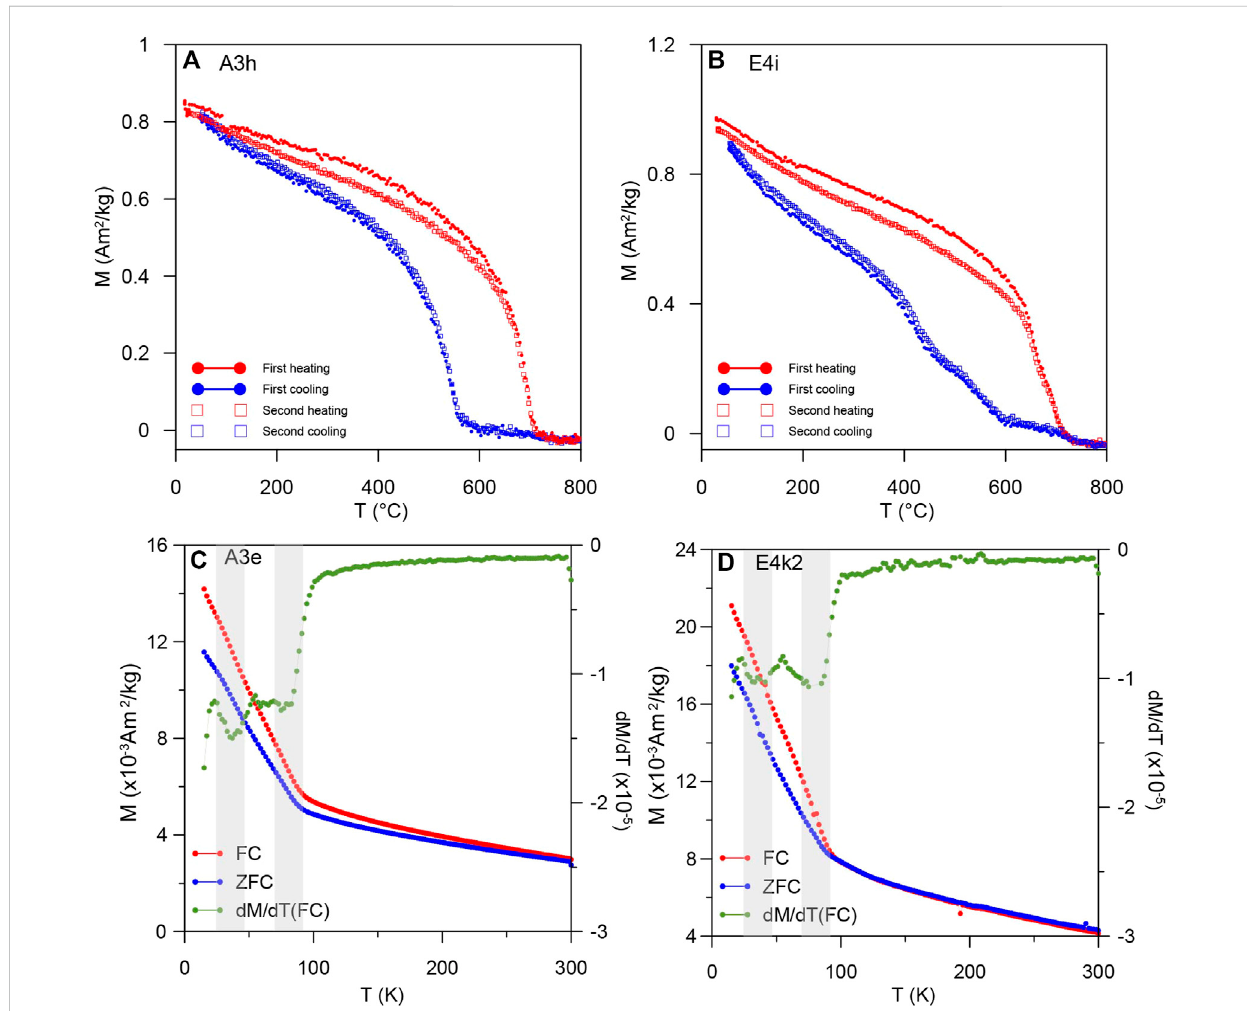
FIGURE 12 (A) and (B) Representative variations of magnetization versus temperature. Specimens are processed in air in an applied fi eld of ~1 T with heating/ cooling rates of 30 ° C/min. (C) and (D) Low-temperature FC and ZFC curves of representative specimens. Green lines are fi rst-order derivative curves of FC data. Gray areas represent intervals of transition